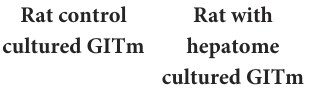
TABLE 1 Enzyme activities related to carbon sources consumption in GITm.